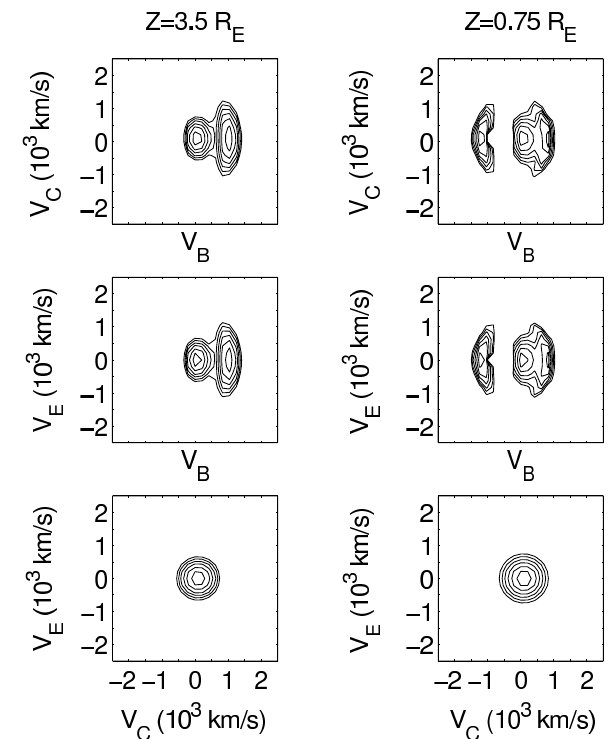
Fig. 11. Two dimensional cuts through model distribution functions calculated at X =-20 R E and (left column) Z =3.5 R E and (right column) Z =0.75 R E . The velocities are expressed in terms of the direction of the magnetic field ( V B ), electric field ( V E ), and con- vection ( V C ). The top row shows the cut in the V B − V C plane, the middle row shows the cut in the V B − V E plane, and the bottom row is the cut in the V C − V E